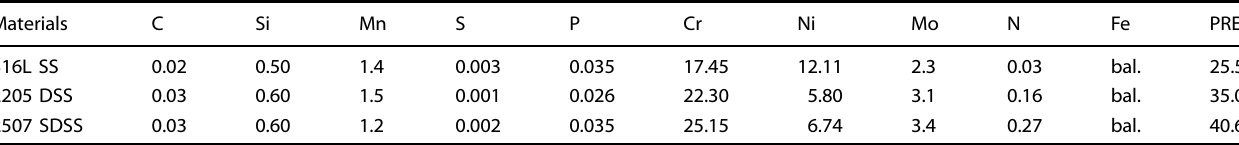
Table 4. Chemical compositions and the calculated PRE N values for three stainless steels (wt%). Materials